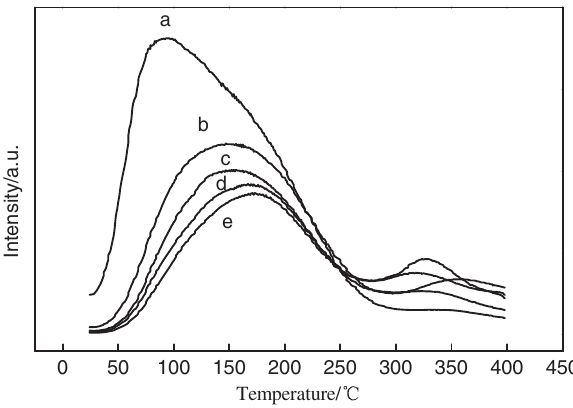
Figure 6: (a) Thermal luminescence spectrum of 70ZnO – 10P 2 O 5 – 20SiO 2 – 5Tb 3 þ and (b, c, d and e) 1% BaO, 2% BaO, 5% BaO, 10% BaO replace the same content of